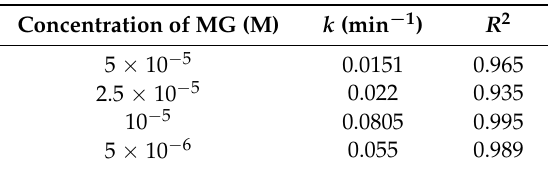
Table 2. Comparison of pseudo first-order model parameters, rate constants ( k , min − 1 ) and R 2 under different concentrations of MG.